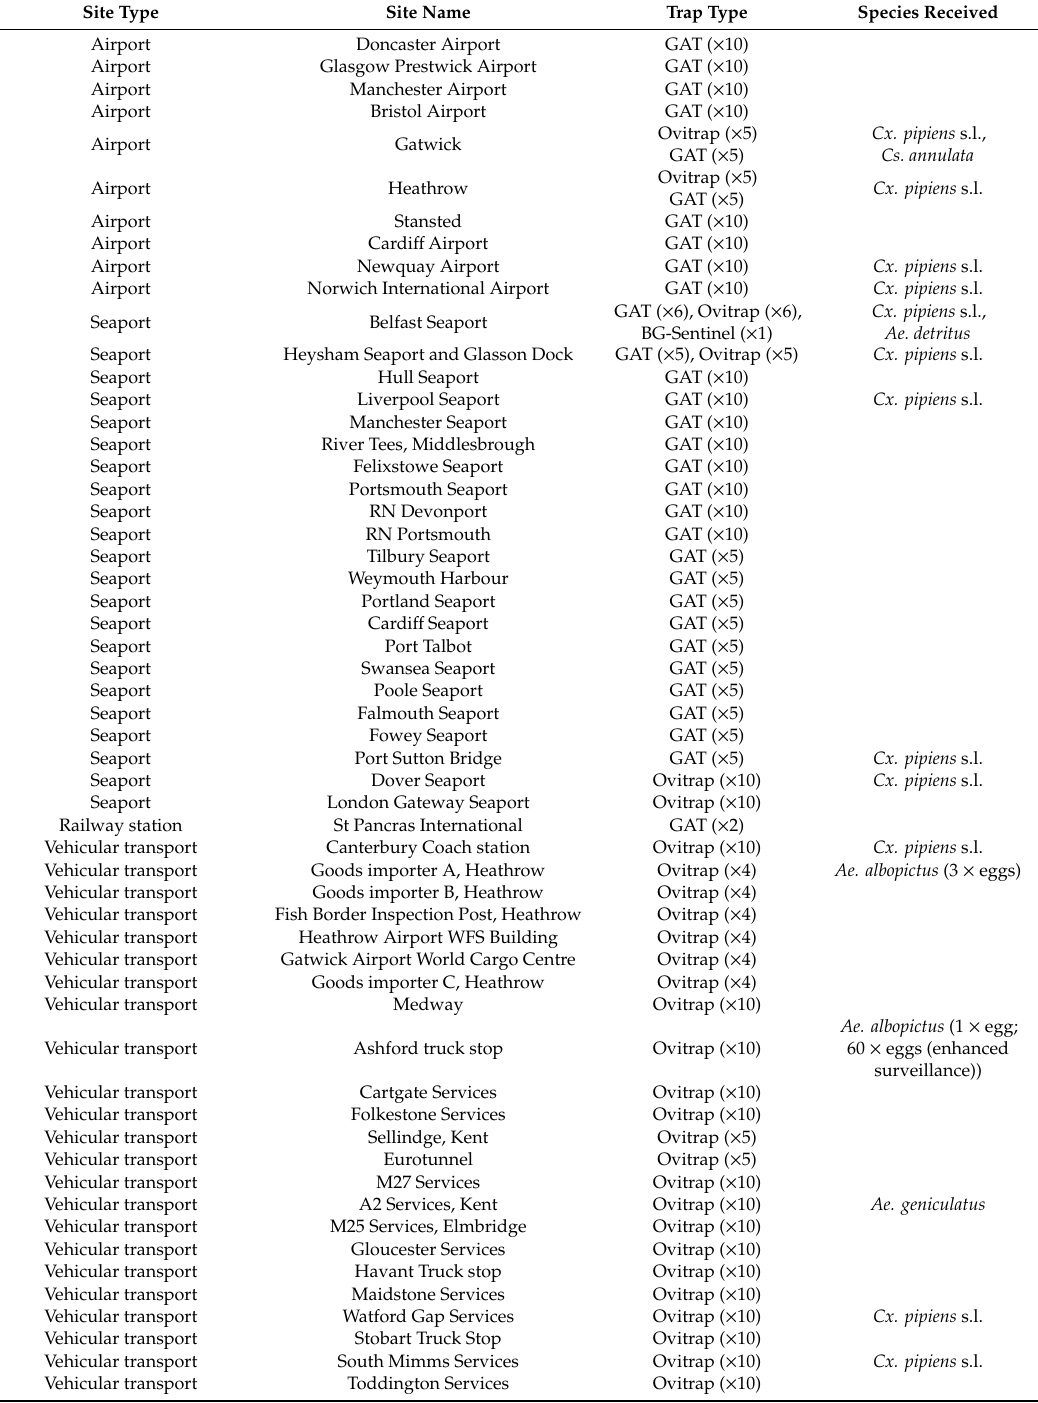
Table 1. Mosquito species recorded, trap type (BG-Sentinel, GAT, ovitrap), and site type (airport, seaport, vehicular transport, railway station) shown for each surveillance site. Numbers shown in brackets under trap type indicate the number of